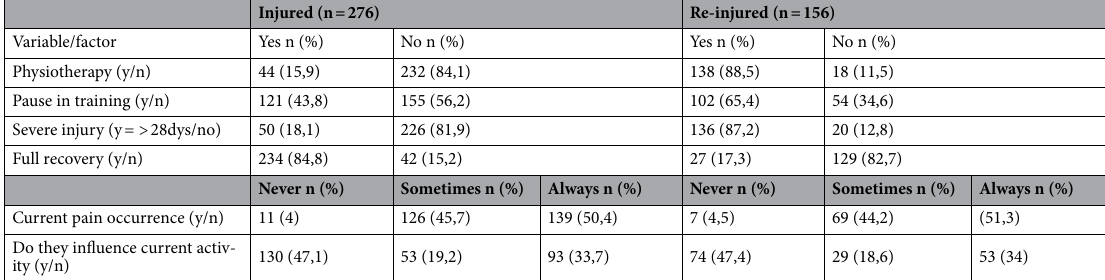
Table 3. Distribution of pole dancers (n,%) with different codes (yes/no or never/sometimes/always) of analysed factors. Y = yes, n = no, dys = days.